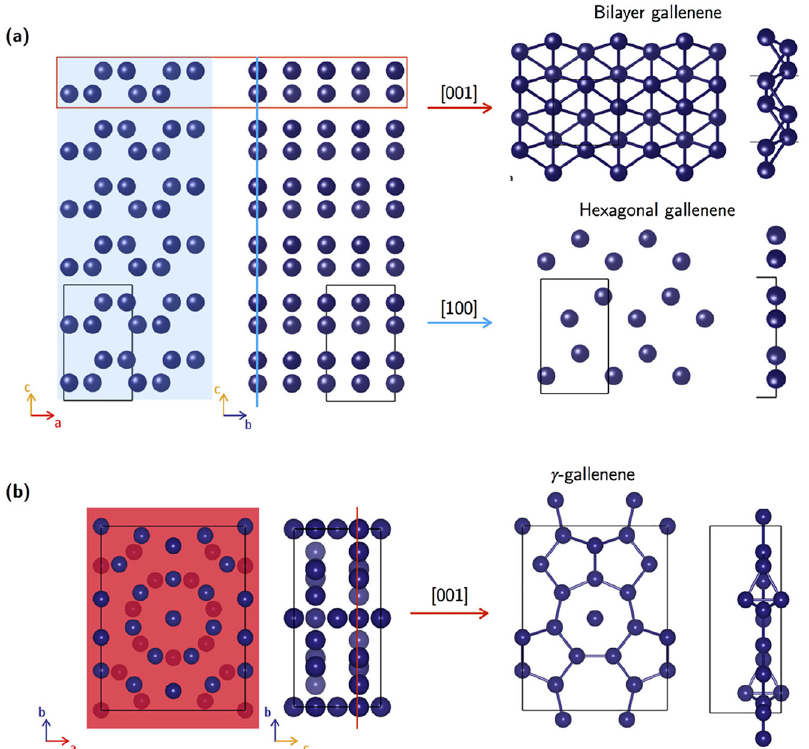
Figure9: (a)Crystallinestructureof α -Gaand its exfoliation along [100] and[001] leading to bilayer and hexagonal 2D gallenene forms. (b) Crystalline γ -Ga and its exfoliation along [001]; the relaxation of this structure leads to γ -gallenene.